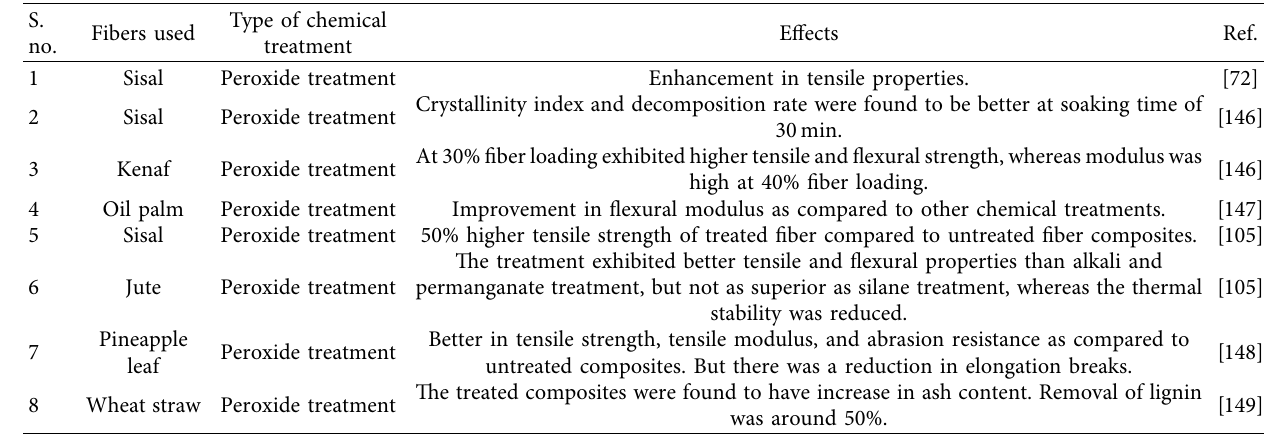
Table 5: Effect of peroxide treatment on various